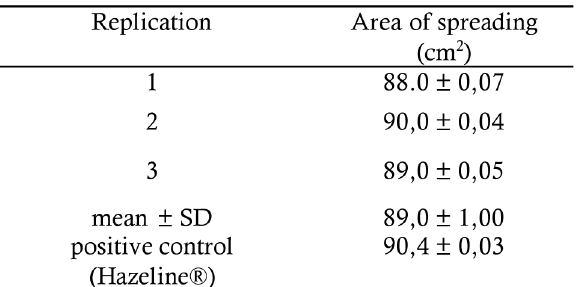
Based on the spreading result, the w/o/w multiple emulsion showed no significant different in area of dispersion compared to the positive control (P=0.136).